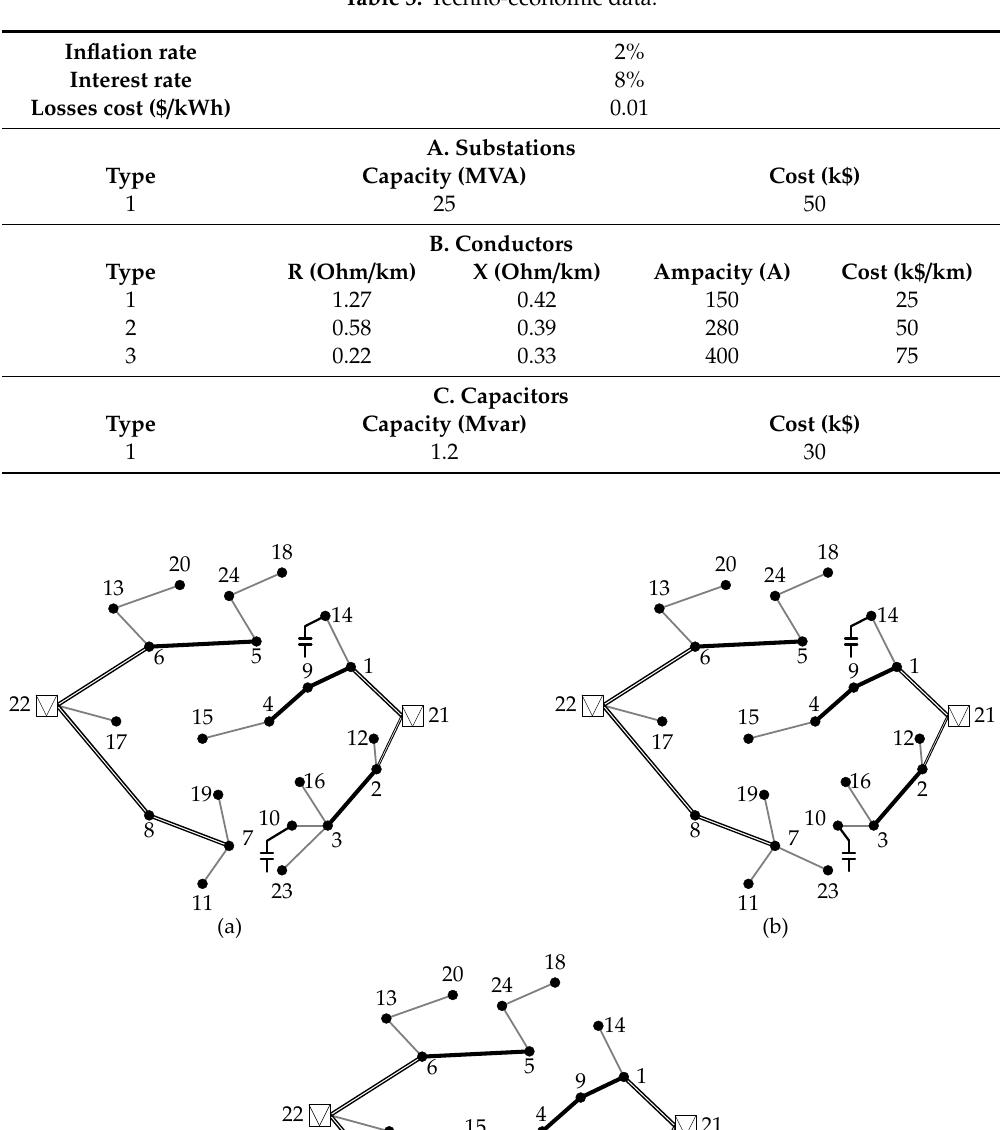
Table 3. Techno-economic data.